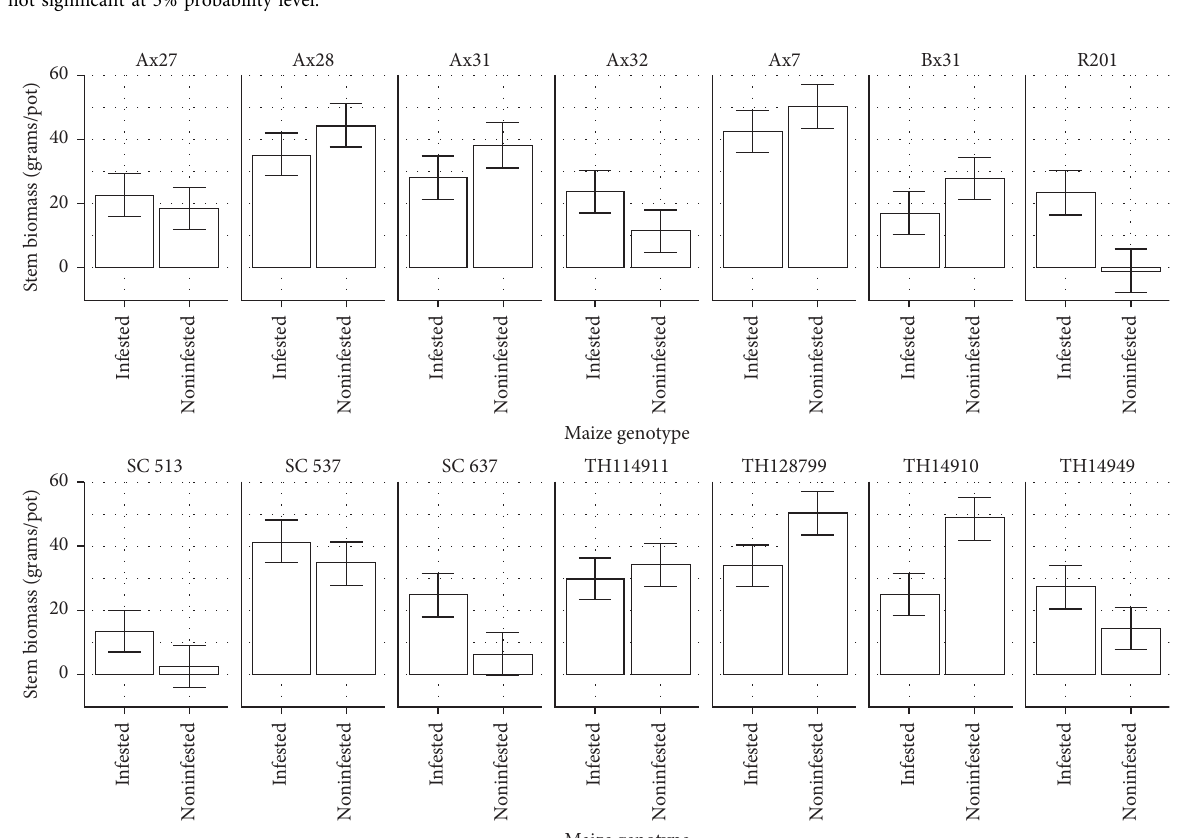
Figure 1: Stem biomass weight of individual maize genotypes across Striga asiatica infested and noninfested levels in pot experiment. Error bars indicate the standard errors of the difference between